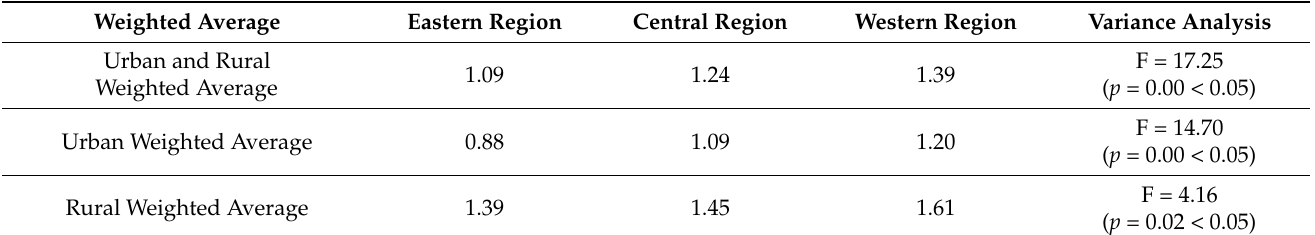
Table 2. Calculation of urban and rural care service demand in eastern, central, and western regions.